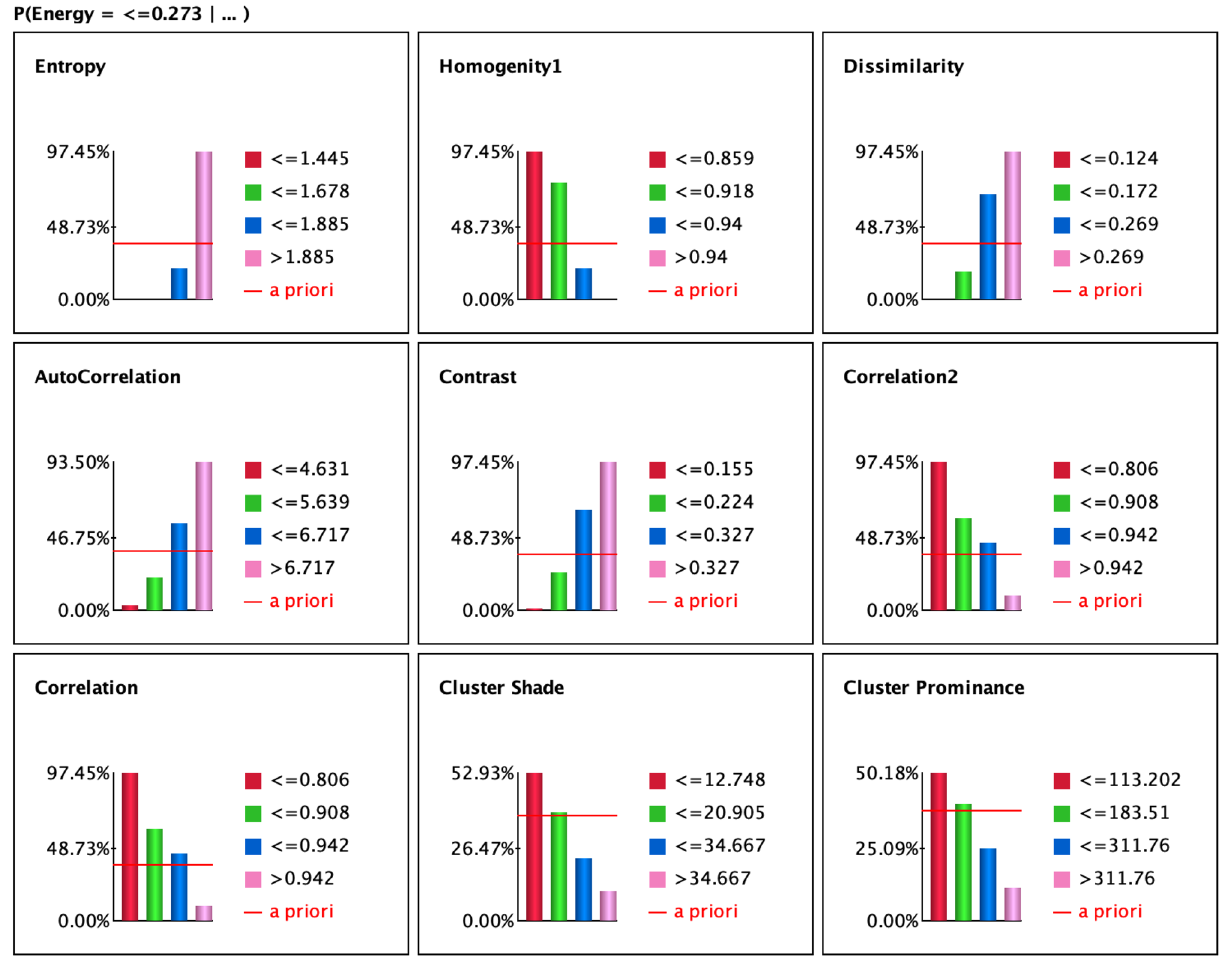
Figure 9. Target’s posterior probabilities for outcome variable Energy = ≤ 0.273.